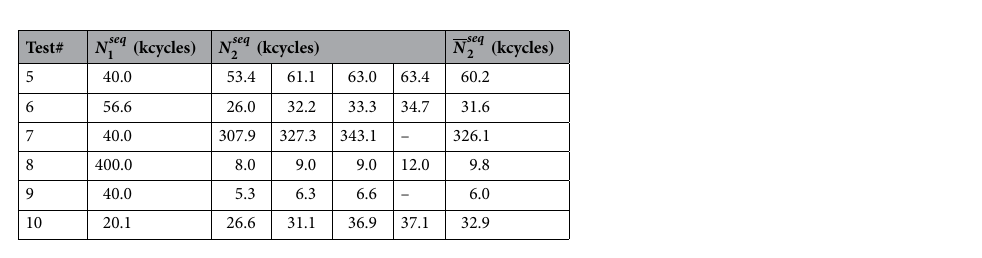
Table 3. Lifetime results of sequenced